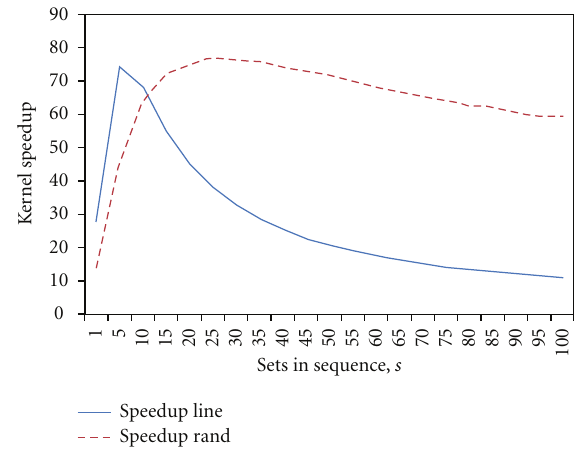
Figure 10: N-body kernel speedup obtained by the traversal cache framework for di ff erent amounts of datapath replication s . N = 100k, theta =